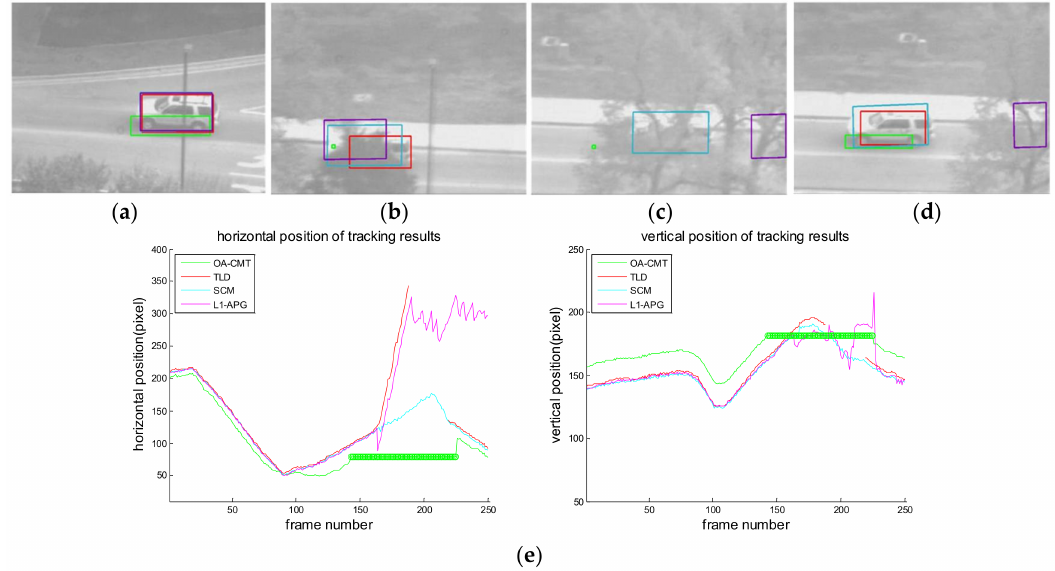
Figure 20. Computer simulation result of imagery ID 5. ( a ) Normal tracking status (original image); ( b ) OA-CMT turns to memory tracking status when the tank is hidden by trees; ( c ) other trackers are wandering; ( d ) TLD, SCM and OA-CMT re-lock target successfully after blind time; ( e ) tracking trajectories of each tracker. TLD follows the wrong target during blind